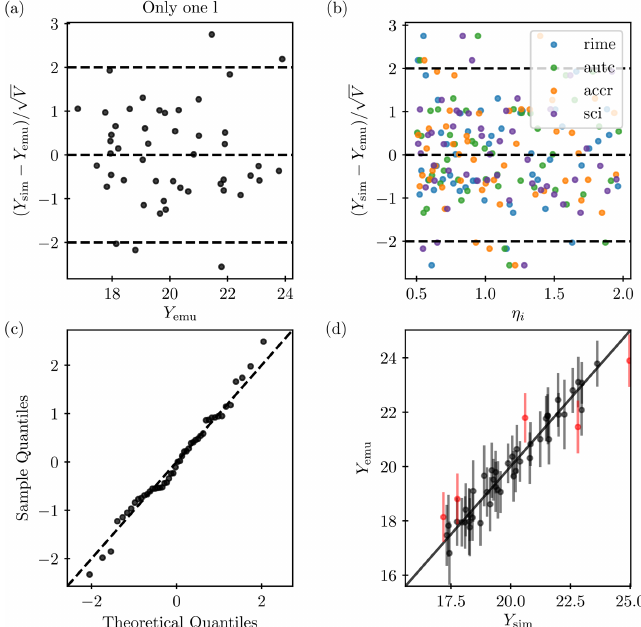
Figure D1. Validation of the emulated angular amplitude spectrum of degree l = 6 for the LWP.